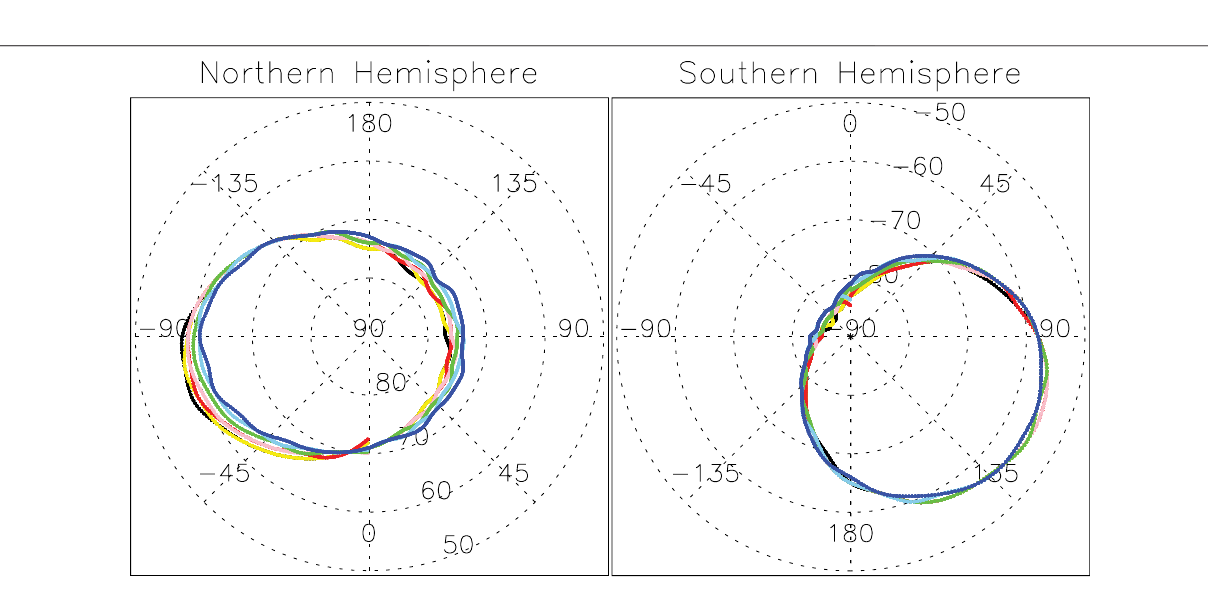
FIGURE 9 | Image of EPWs with 200 MV under different background magnetic fi elds for different years which are marked with different colors. The colors “ black, ” “ yellow, ”“ red, ”“ pink, ”“ green, ”“ skyblue, ” and “ blue ” represent1965,1975,1985,1995,2005,2015,and2025,respectively.TheleftoneistheboundaryoftheEPWin the northern hemisphere, and the right one is in the southern